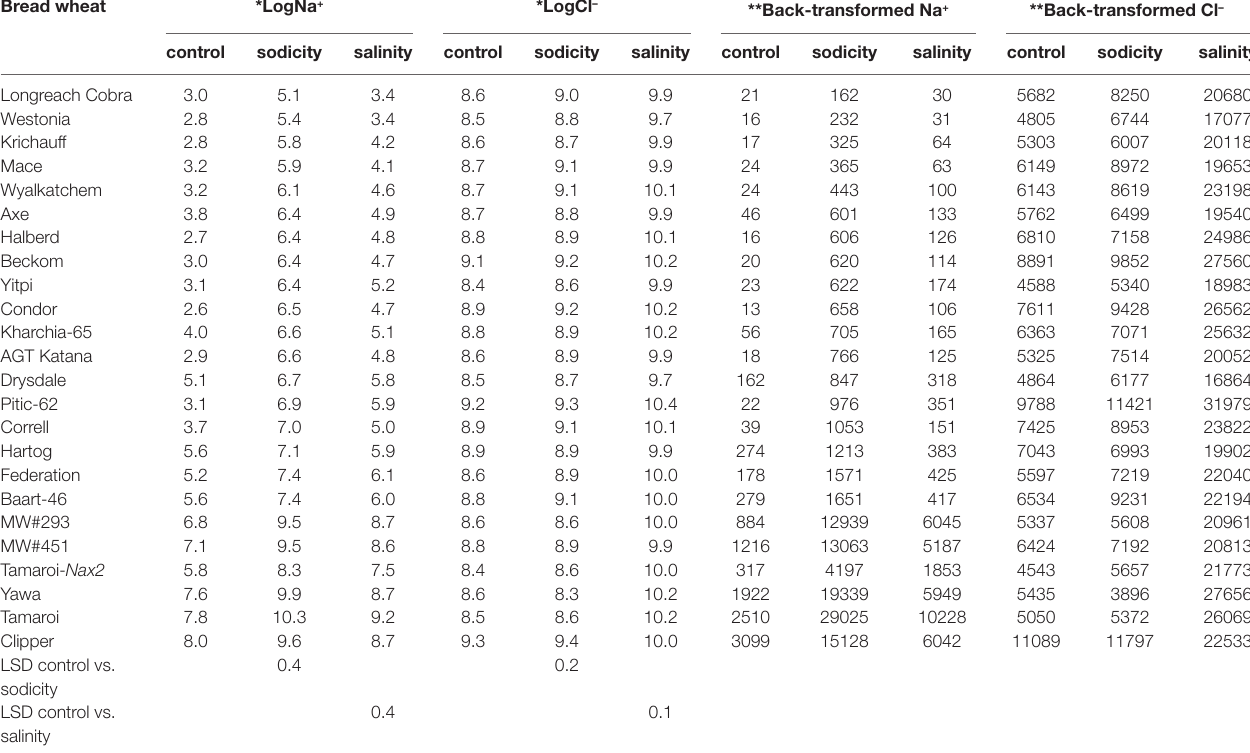
TABLE 2 | Best linear unbiased estimates for leaf Na + and Cl - concentrations (mg kg -1 DW) in 20 bread wheat entries ( Triticum aestivum L.), three durum wheat entries ( Triticum turgidum subsp durum cv. Tamaroi, Tamaroi- Nax2 , and Yawa), and one barley cultivar ( Hordeum vulgare L.cv. Clipper) under control, salinity (100 mM NaCl), and sodicity (8 g kg -1 Na + -humate) in Experiment 3 (n =